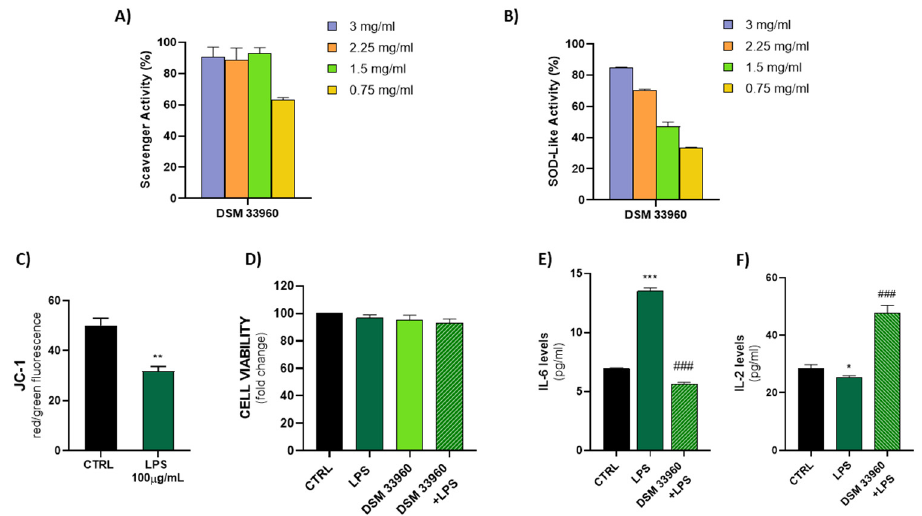
Figure 3. DPPH scavenger and SOD-like activity explicated by the CA15 (DSM 33960) strain tested at different concentrations (3, 2.25, 1.5, and 0.75 mg/mL) (Panels A , B ); LPS treatment (100 µg/mL) effect on mitochondrial membrane potential (Panel C ) (** p < 0.005 vs. CTRL); Assessment of Caco-2 cell viability after treatments (Panel D ); Measurement of IL-6 and IL-2 levels in cell supernatants by ELISA (Panels E , F ) (* p < 0.05, *** p < 0.0005 vs. CTRL; and ### p < 0.0005 vs. LPS).